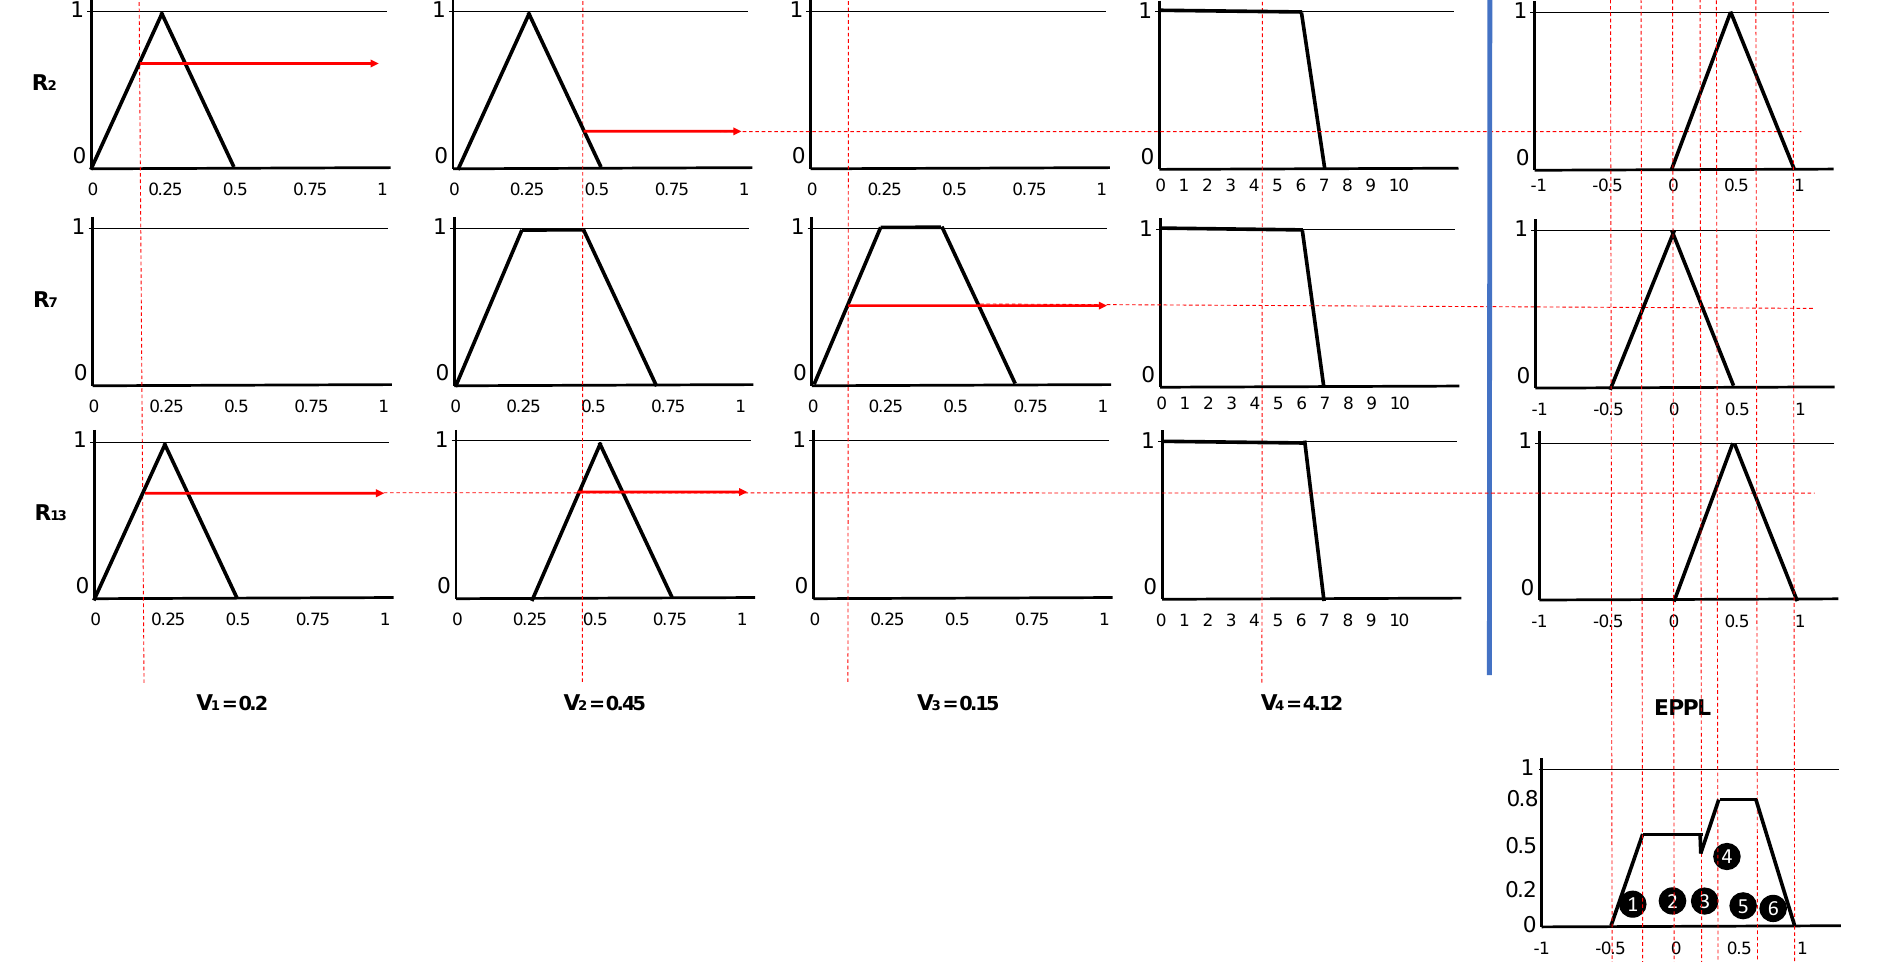
Figure 10. Visual representation and results when applying the aggregation method (max) related to example